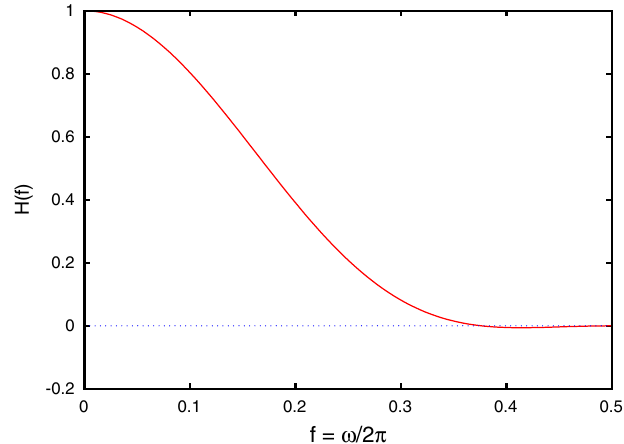
FIG. 3. (Color) The transfer function of the filter in frequency domain.